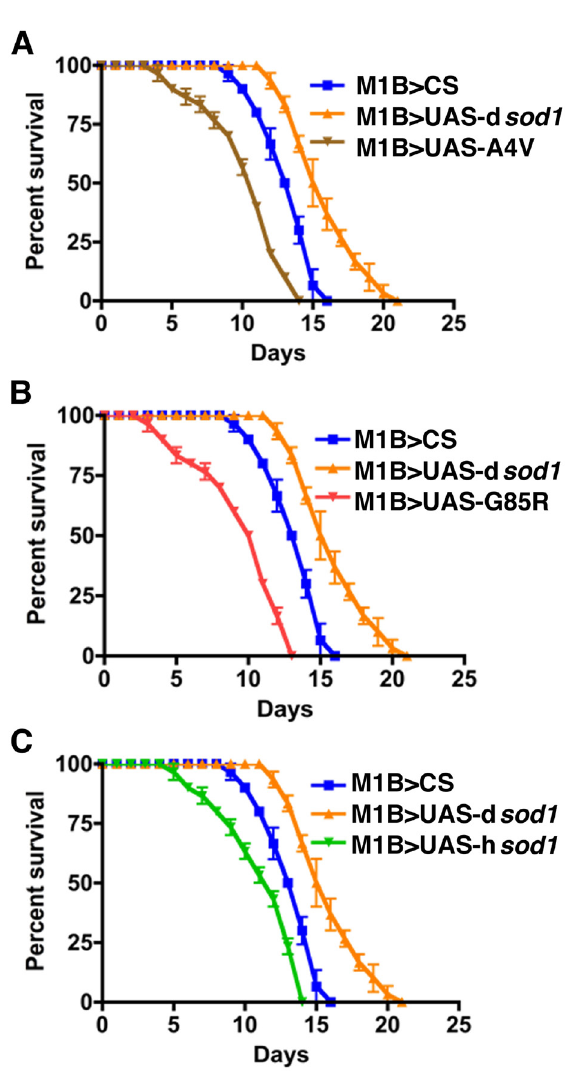
Figure S2. Human SOD1 over-expressed in glial cells enhances the effect of BMAA on reducing the longevity of flies. Shown are survival rates of 35 day-old male sod1 transgenic flies under 3 mM BMAA treatment (10 flies per vial). Panels A , B , and C represent flies expressing mutant human A4V, G85R, wild type SOD1 proteins. The 50% survival rate of A4V, G85R, and hSOD1 when compared with dSOD1 is decreased by 31, 38, and 38%, respectively. Differences were considered statistically significant if p<0.02 and were calculated by a paired t-test method by using Prizm software (n=30 for each genotype).